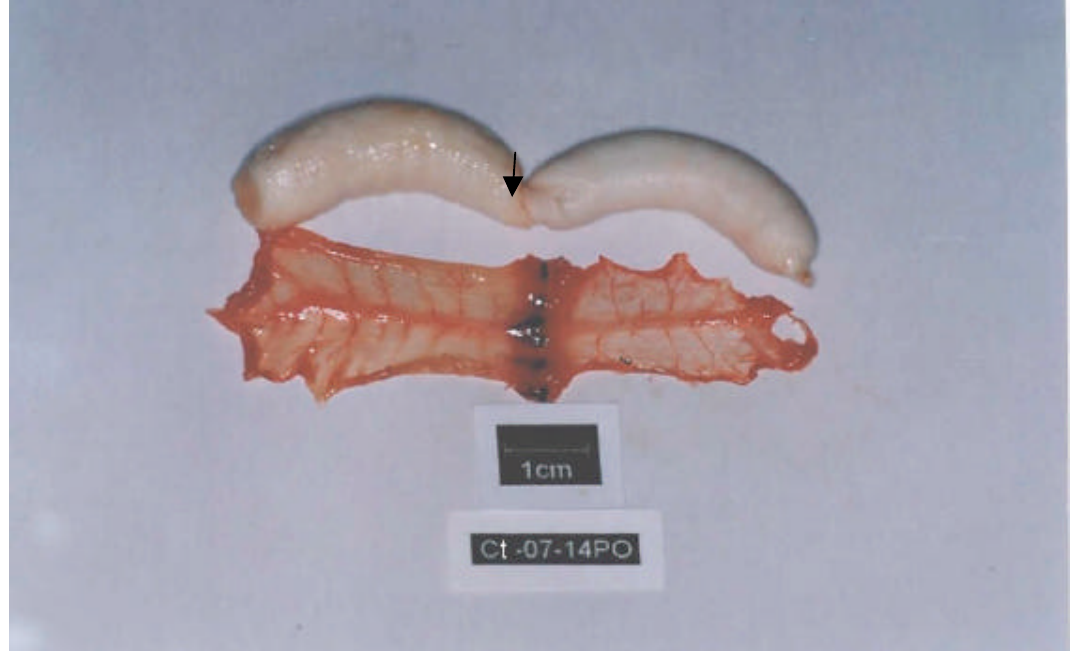
FIGURA 7 – Fotografia da peça operatória da anastomose jejuno-jejunal, mostrando a estenose tanto no molde como na face interna (mucosa) na linha de cicatrização (setas). Sub-grupo Cf (adesivo biológico – 6 pontos) no 14º dia de